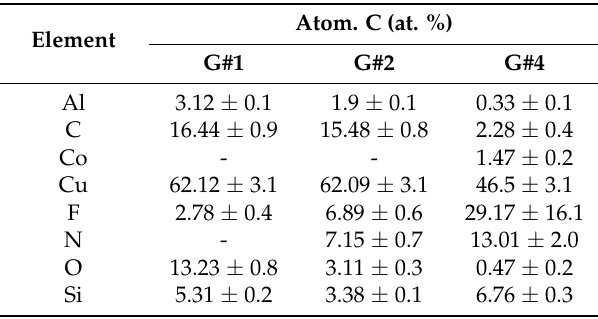
Figure S1: SEM image of deposited Ag after step